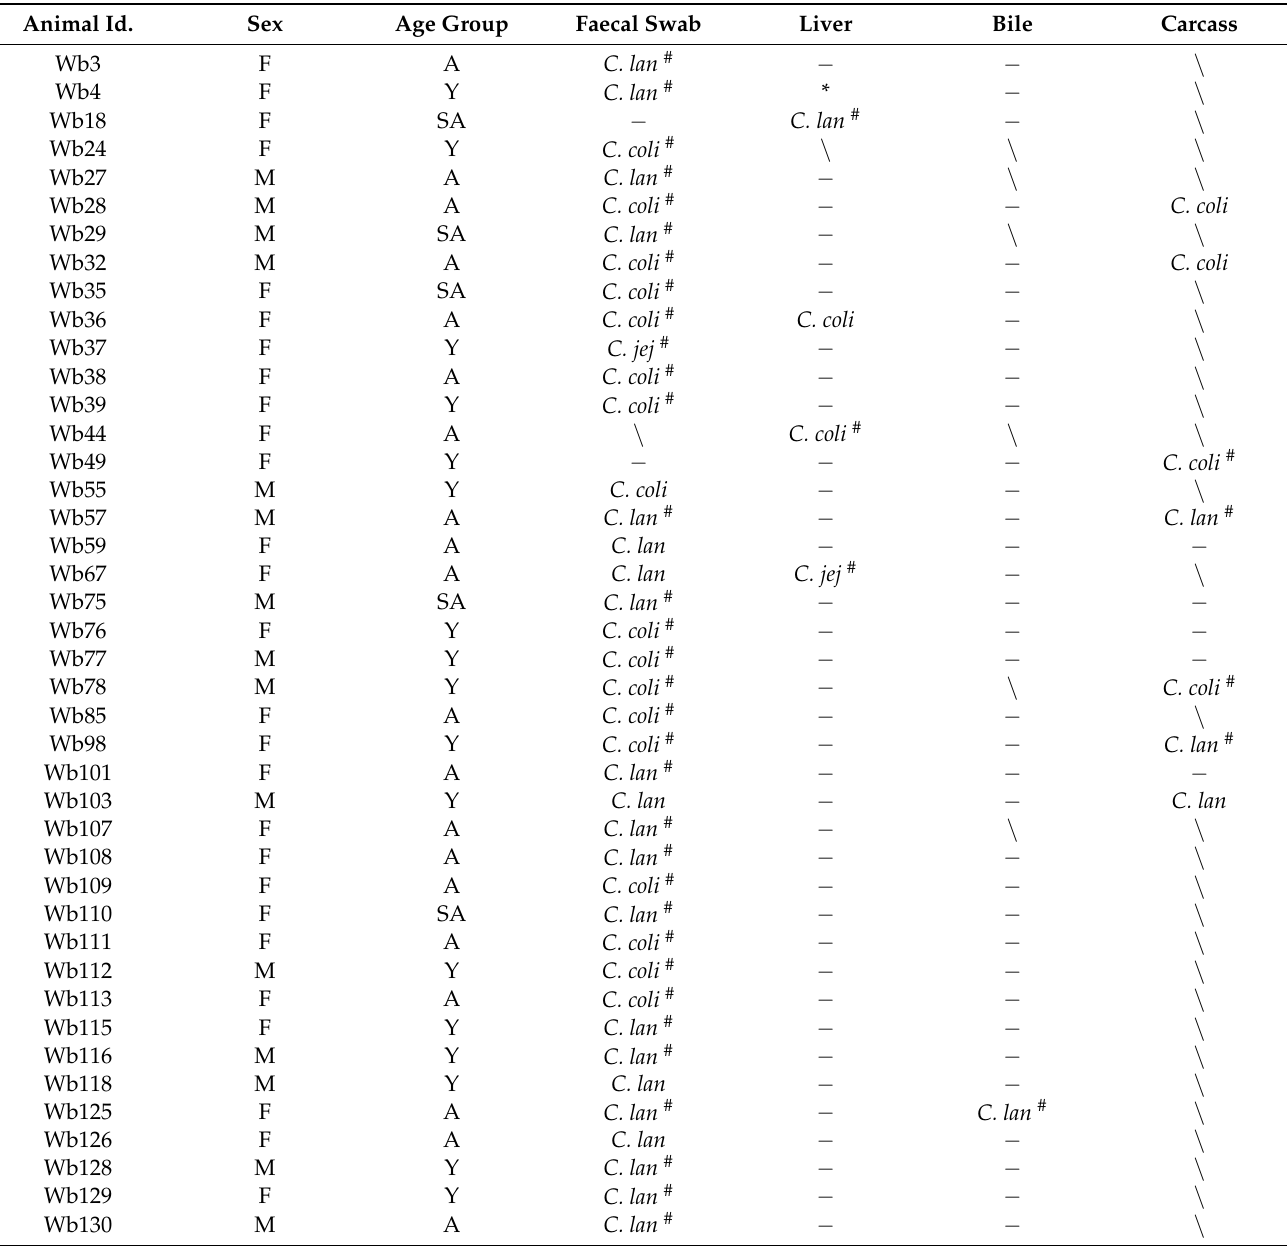
Table 3. Identity, sex, and age group of wild boars harbouring genotypically confirmed Campylobacter . Animal